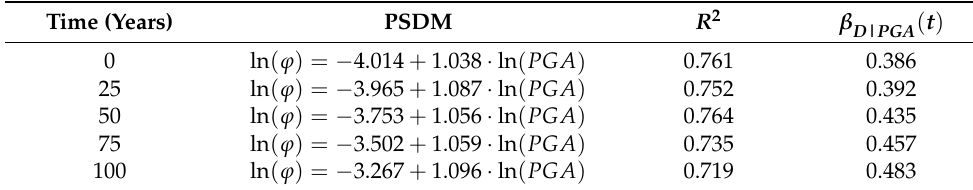
Table 4. PSDMs of the aging RC